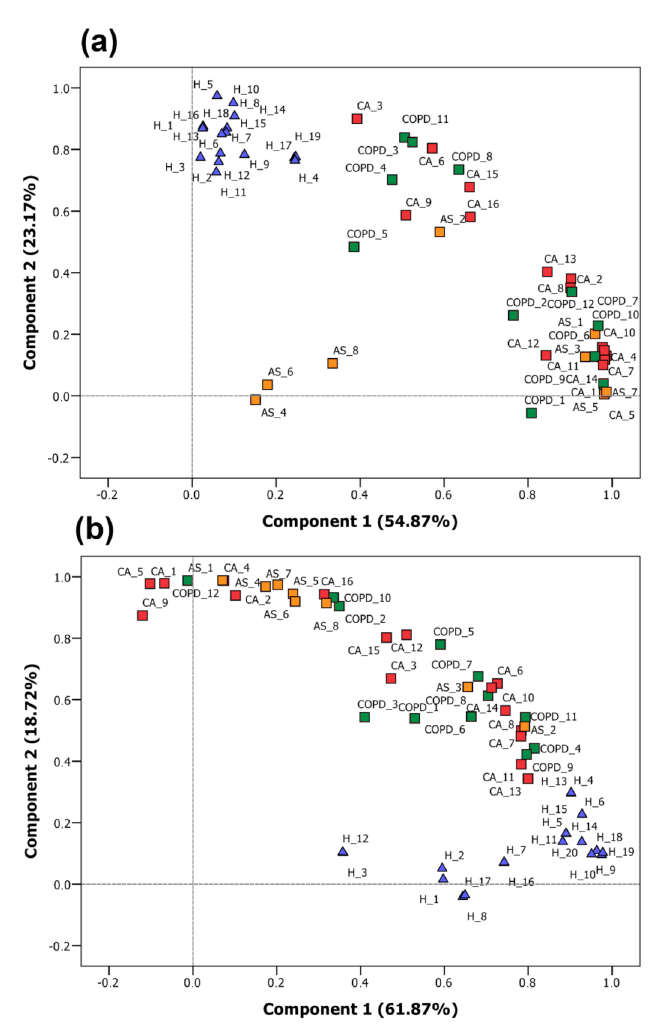
Figure 2. PCA plots using as input ( a ) VOCs’ responses in global profile analysis, ( b ) responses of the targets quantified in the samples (triangles = control samples; squares = positive